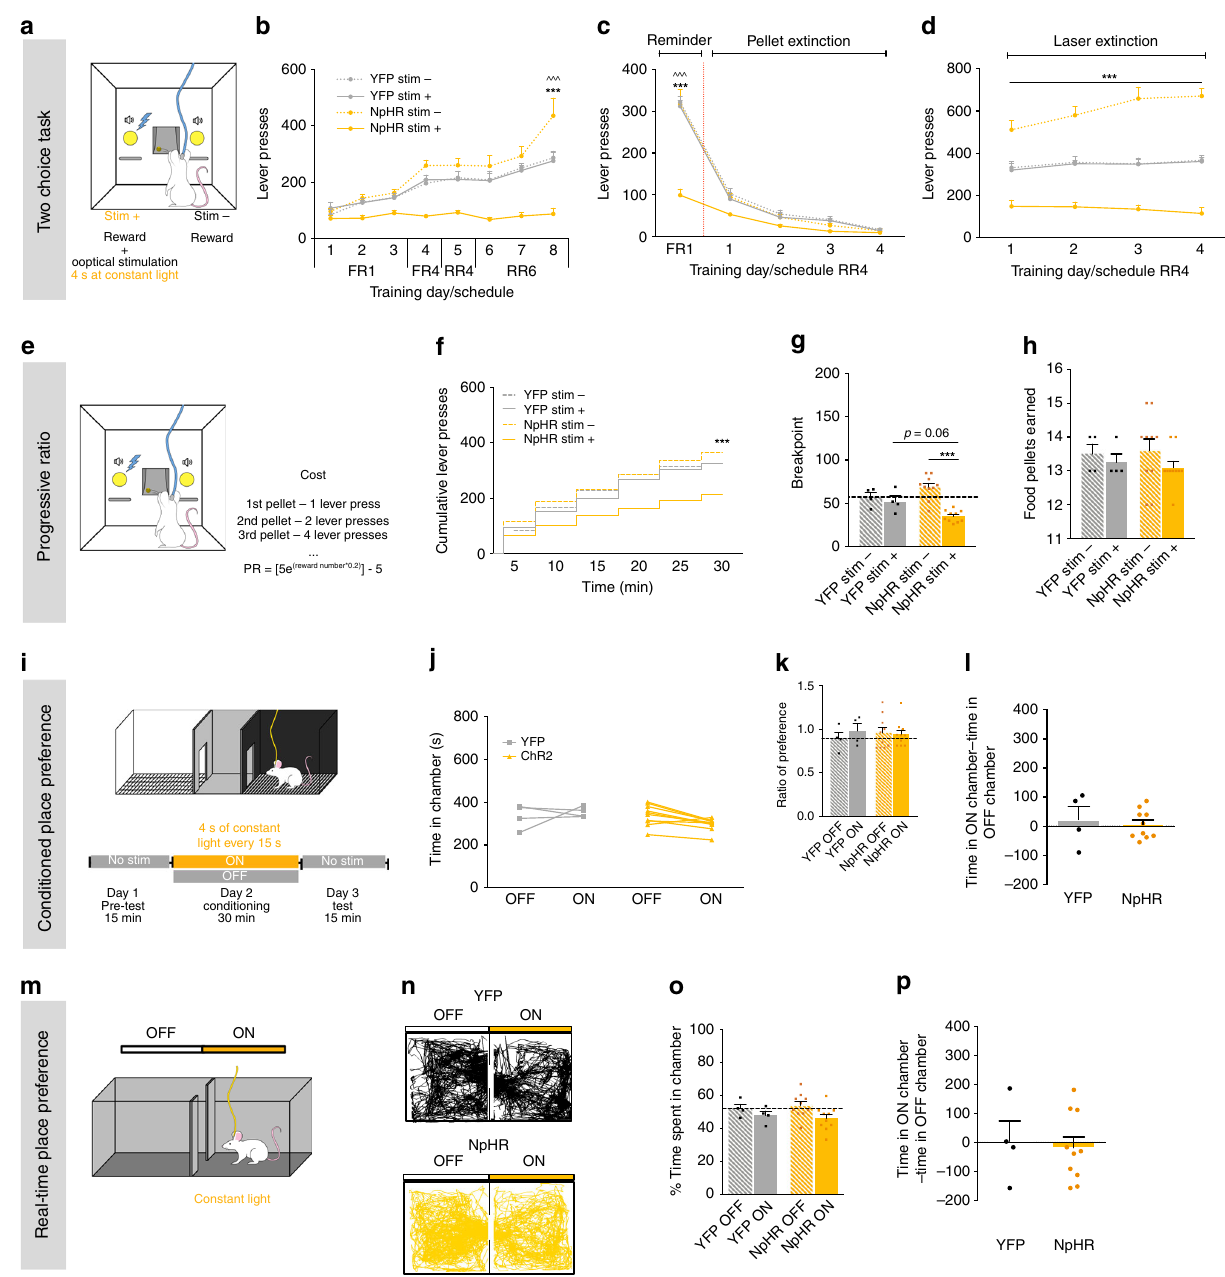
Fig. 3 LDT-NAc optical inhibition decreases preference and motivation. a Schematic representation of the two-choice task. Pressing stim- lever yields one food pellet and pressing stim + lever delivers a pellet + optical inhibition of LDT-NAc inputs (4s at constant light). b Time-course representation of the responses in NpHR ( n = 10) and YFP ( n = 4) rats. Optogenetic inhibition of LDT-NAc terminals shifts preference for the non-stimulated lever (stim-) in NpHR animals, but no preference is observed in YFP group. c In pellet extinction conditions, both groups decrease responses for both levers. d In laser extinction conditions, pressing either lever originates the delivery of a pellet, and stim + no longer yields laser stimulation. NpHR animals still prefer stim- lever; YFP animals do not manifest preference. e Progressive ratio task. f Cumulative presses performed during the progressive ratio task show that NpHR animals press less on stim + lever. g Decrease in breakpoint for stim + lever in NpHR animals. h Number of food pellets earned during progressive ratio sessions. i CPP and m RTPP paradigms, in which one chamber is associated with NpHR-mediated inhibition of LDT-NAc projections (ON side). j Total time spent in the OFF and ON sides. k Ratio of preference after CPP conditioning and l time difference on the ON and OFF sides, showing no preference/ avoidance in any of the groups. n Representative tracks for an NpHR and a YFP animal during RTPP. o Percentage and p difference of time spent on the ON and OFF sides, showing no difference between groups. Values are shown as mean ± s.e.m. *refers to difference between NpHR stim + and stim- levers, RM 2way ANOVA; ^refers to difference between NpHR stim + and YFP stim + levers, RM 2way ANOVA. * p < 0.05; ** p < 0.01; *** p <